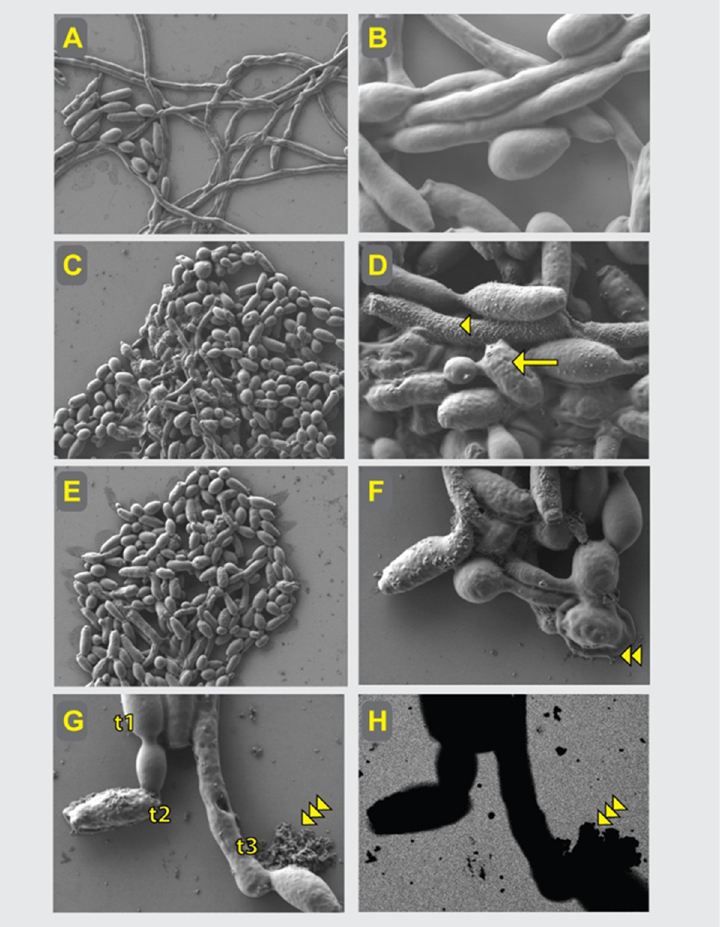
Figure 4. SEM analysis of the compounds’ effects on the C. albicans cells. Control cells ( A , B ) demonstrating normal appearance of C. albicans , with long hyphae stage well-represented ( A ) and uniformly smooth surface ( B ). Compound FLC-TP10-7-NH 2 , ( C , D ), in contrast, resulted in reduction of hyphae numbers ( C ), roughed cells surface (arrow) in large part of cell population, granularities (arrow- head), perforations and increased debris ( D ). Compound FLCpOH-TP10-NH 2 , ( E – H ) demonstrated signs of stronger toxicity against C. albicans , lack of hyphae ( E ), with intense roughing of the cell surface and membrane disintegration or spreading (double arrowheads) ( F ), frequent perforations and granularities ( G ), membrane blebbing and more debris. ( G , H ) Different stages of deleterious effects of the compound, from mild (t1), through roughing (t2) to perforation and fragmentation of cells (t3). Chemical contrast imaging ( H ), correlated pixel-to-pixel with topography imaging. ( G ) Improved identification of blebbing and fragmentation of C. albicans cells (triple arrowheads). Gray appearance of the substrate in ( H ) stems from silicon polished crystal and facilitates detection of multiple organic fragments with dark appearance in ( H ), by chemical contrast mapping of